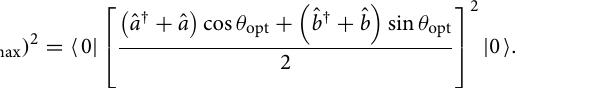
Figure 3c, d show (cid:31) X min (cid:31) X max as a function of g . When the atomic subsystem is well approximated as a bos- 1 / 4 31,32 , which is onic system, this quantity should satisfy the Heisenberg uncertainty principle � X min � X max ≥ 1 / 4 is obtained for g < √ ω a ω b / 2 , satisfied in all the cases in Fig. 3c, d. Further, we can find that � X min � X max ≈ √ ω a ω b / 2 . When g is larger although (cid:31) X min (cid:31) X max is slightly larger than 1/4 exactly at the critical strength g = than the critical value √ ω a ω b / 2 , (cid:31) X min (cid:31) X max rapidly increases from 1 / 4 . This is because W (α r , β r ) gets two peaks as seen in Fig. 2g, i, and (� X max ) 2 no longer corresponds to the broadening of each peak but represents the square of the distance between the two peaks 17 . In contrast, (� X max ) 2 in Fig. 5c, g represents the broadening of each peak under the spontaneous symmetry breaking (SRPT) in the thermodynamic limit ( N ). → ∞ To see the tendency of squeezing with the increase in N more in detail, in Fig. 4, we plot the ground-state ω a , g 0.5 ω a , and (a,b) N 2 2 , (c,d) N 2 6 , and (e,f) N 2 10 . By increasing wavefunctions W (α , β) for ω b = = = = = β r )/ √ 2 axis (Fig. 4a, c, and e) because of the √ N N , we can find that W (α r , β r ) is getting broader along the (α r −